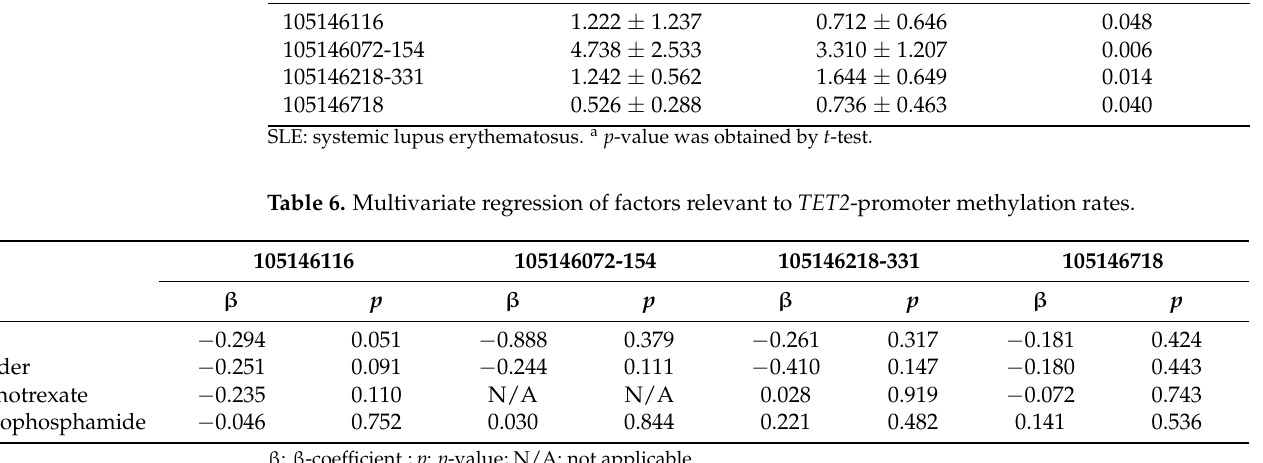
Table 5. Methylation rates at various CpG sites of TET2 promoters. CpG SLE (%) Healthy Donor (%) p a